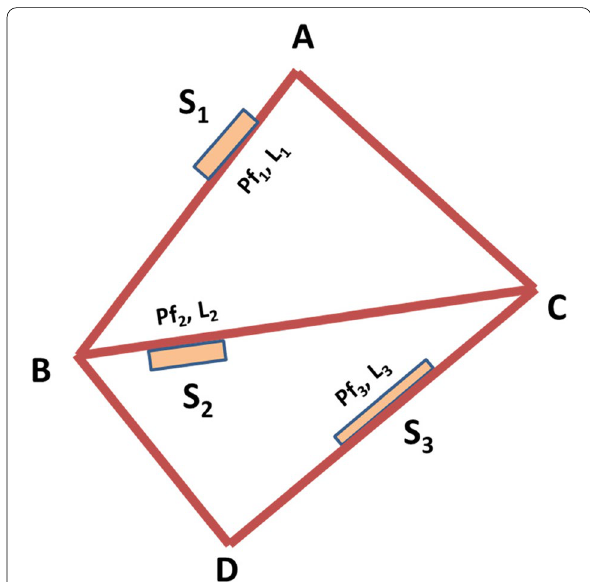
Fig. 1 An example network showing critical slope segments at three